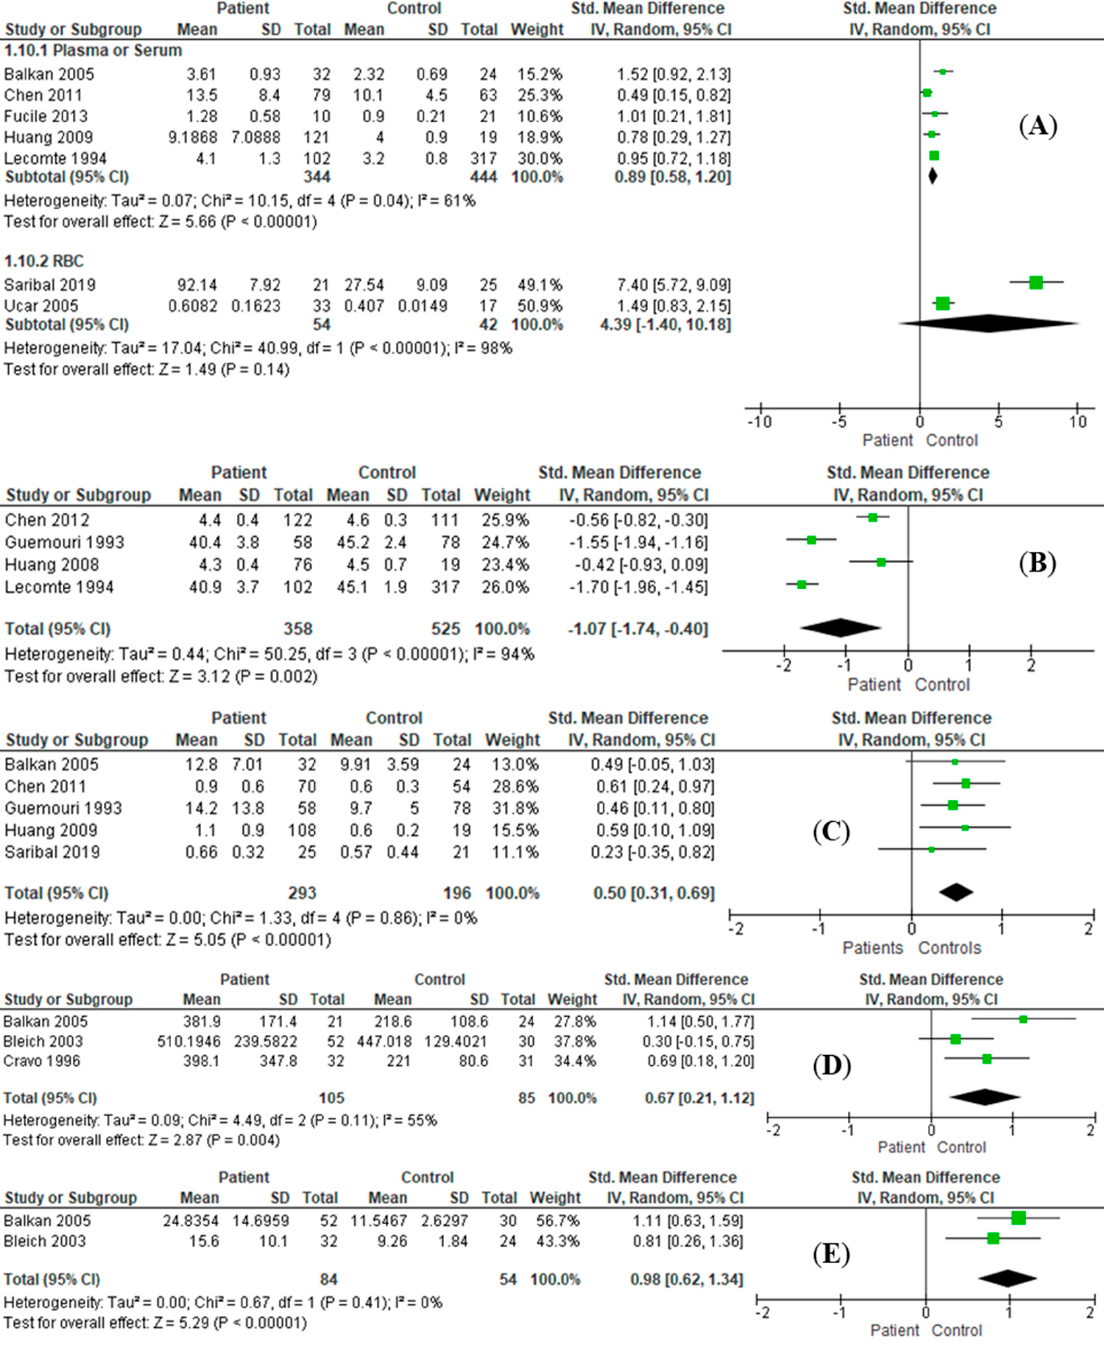
Figure 3. Comparing different levels of antioxidants between alcohol-dependent patients and healthy controls in plasma/serum or RBC. ( A ) Significant difference in MDA was found in plasma/serum (RE: SMD = 0.89, I 2 = 61%, 95%CI = [0.58, 1.20], Z = 5.66, p < 0.001) but not in RBC. In plasma/serum, there were significant differences found in albumin ( B ) (RE: SMD = − 1.07, I 2 = 94%, 95%CI = [ − 1.74, − 0.40], Z = 3.12, p = 0.002), bilirubin ( C ) (RE: SMD = 0.50, I 2 = 0%, 95%CI = [0.31, 0.69], Z = 5.05, p < 0.001), B 12 ( D ) (RE: SMD = 0.67, I 2 = 55%, 95%CI = [0.21, 1.12], Z = 2.87, p = 0.004), and homocysteine ( E ) (RE: SMD = 0.98, I 2 = 0%, 95%CI = [0.62, 1.34], Z = 2.81, p < 0.001). B 12 , vitamin B 12 ; CI, confidential interval; MDA, malondialdehyde; RBC, red blood cell; RE, random effect mode; SD, standard deviation; SMD, standard mean difference.